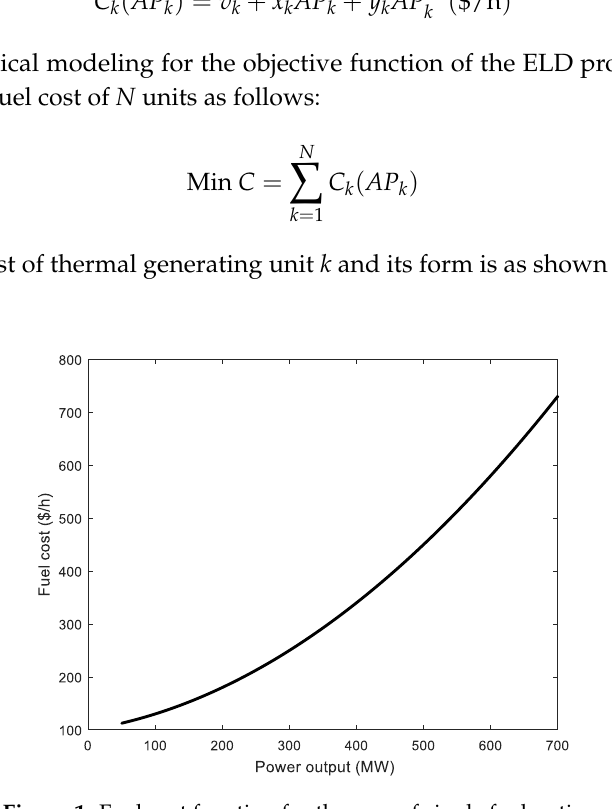
Figure 1. Fuel cost function for the case of single fuel option.